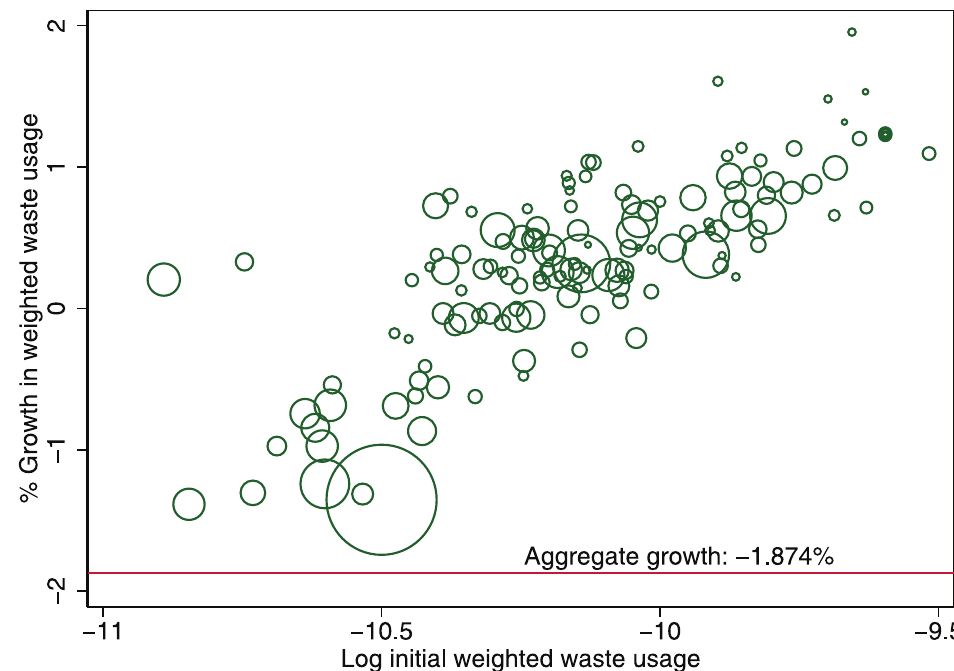
Fig 10. Waste gain due to taxation change ( τ = 0.2 ! τ = 0). Taxation of labor income is changed from being progressive to flat with respect to a city’s cost of